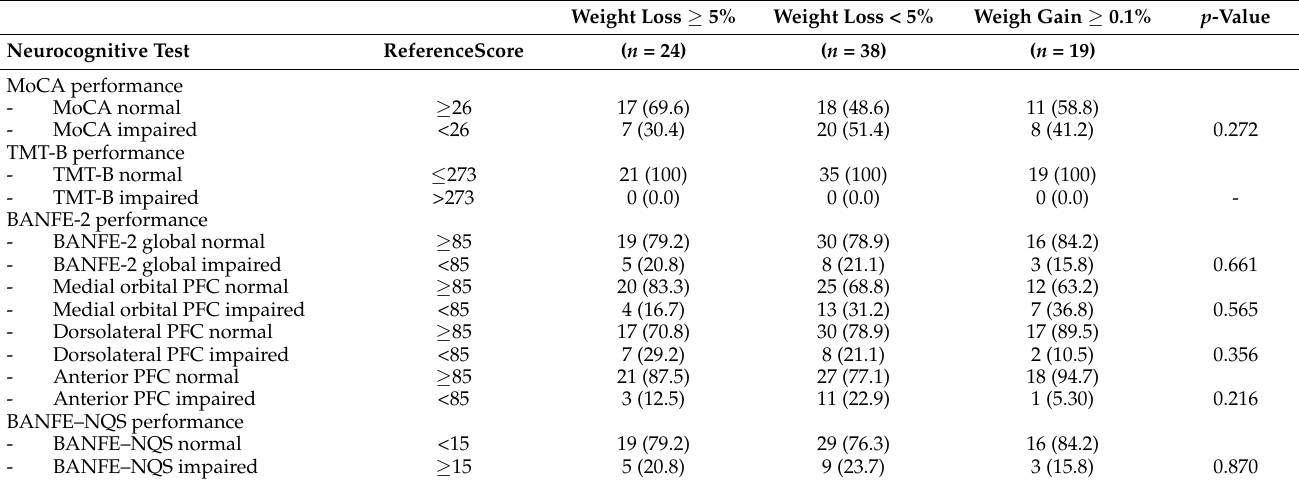
Table 6. Association of baseline cognitive performance with success in weight loss at a six-month